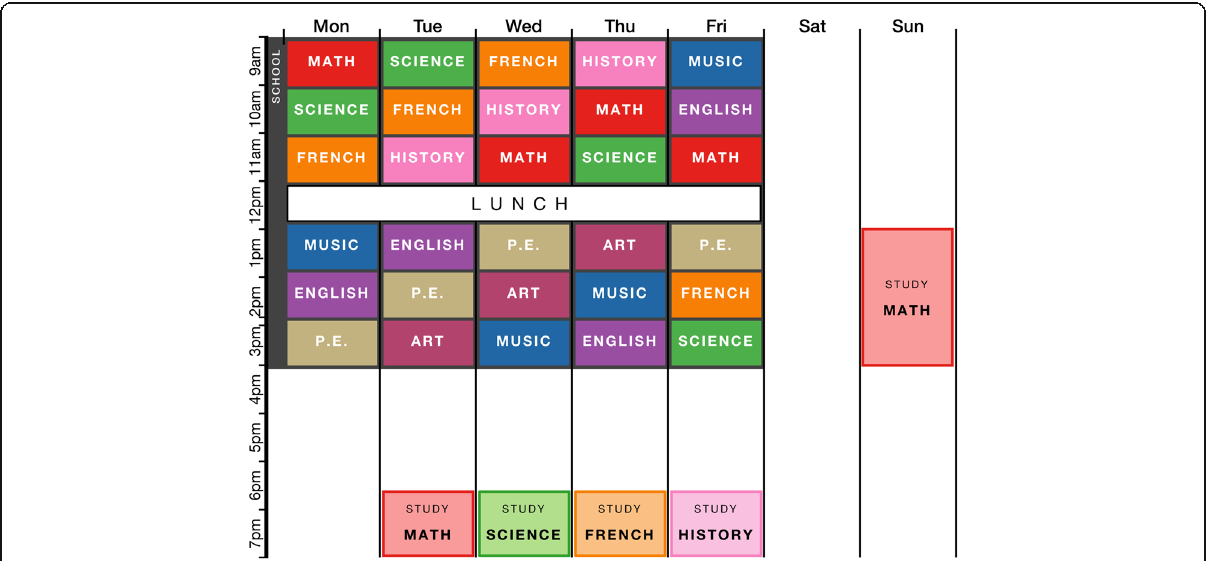
Fig. 1 Spaced practice schedule for one week. This schedule is designed to represent a typical timetable of a high-school student. The schedule includes four one-hour study sessions, one longer study session on the weekend, and one rest day. Notice that each subject is studied one day after it is covered in school, to create spacing between classes and study sessions. Copyright note: this image was produced by the authors